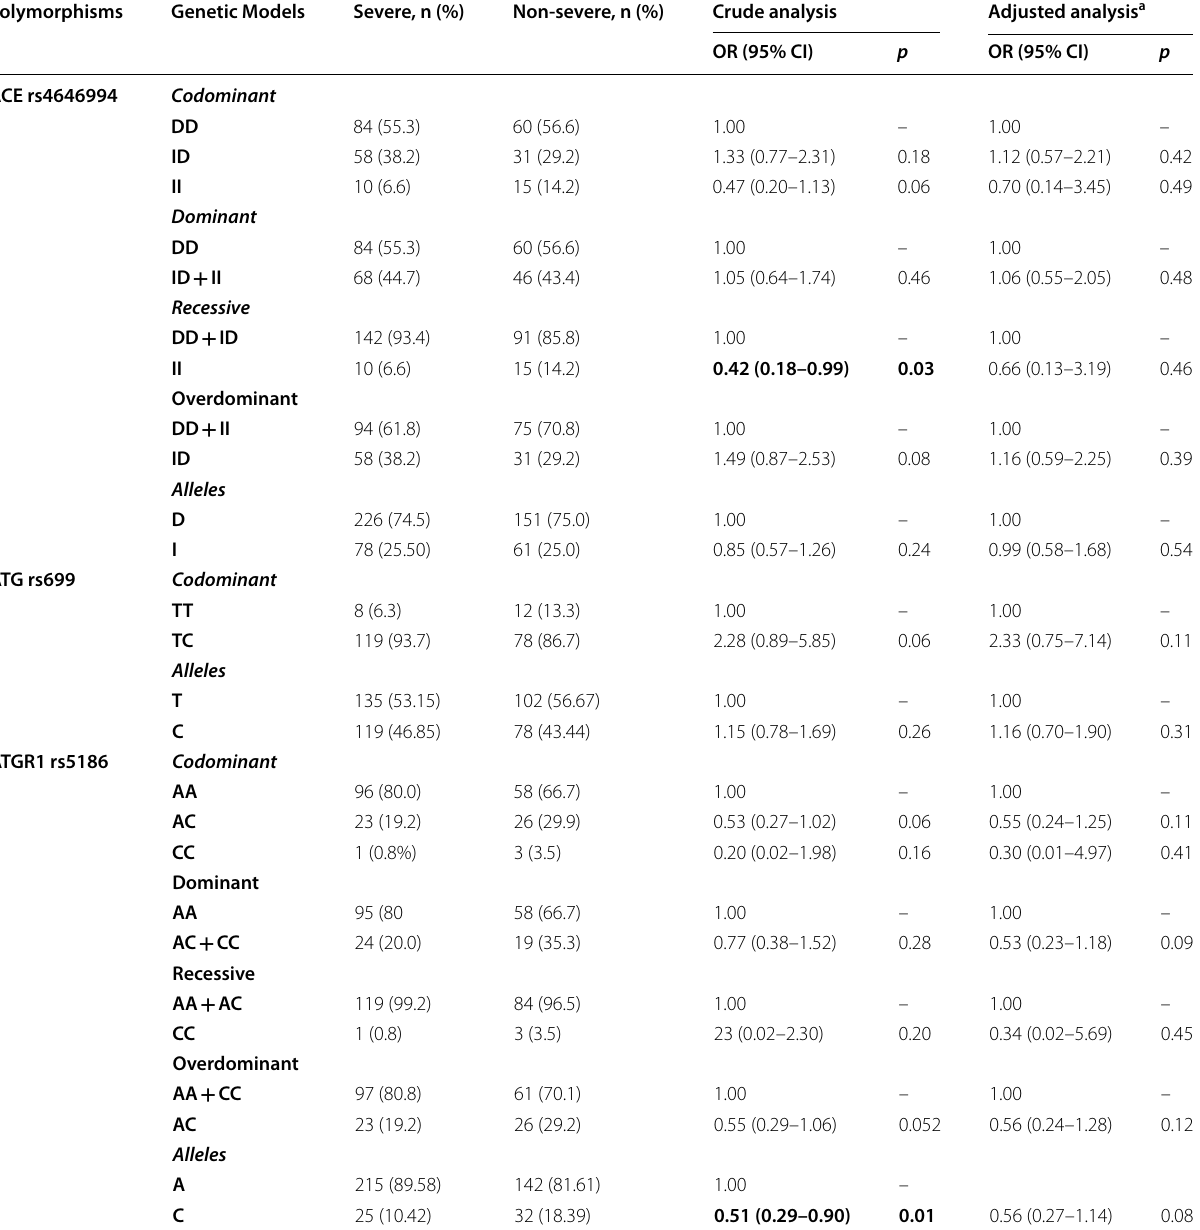
Table 6 Genotypes and allele frequencies of ACE rs4646994, ATG rs699 and AGTR1 rs5186 polymorphisms in non-severe and